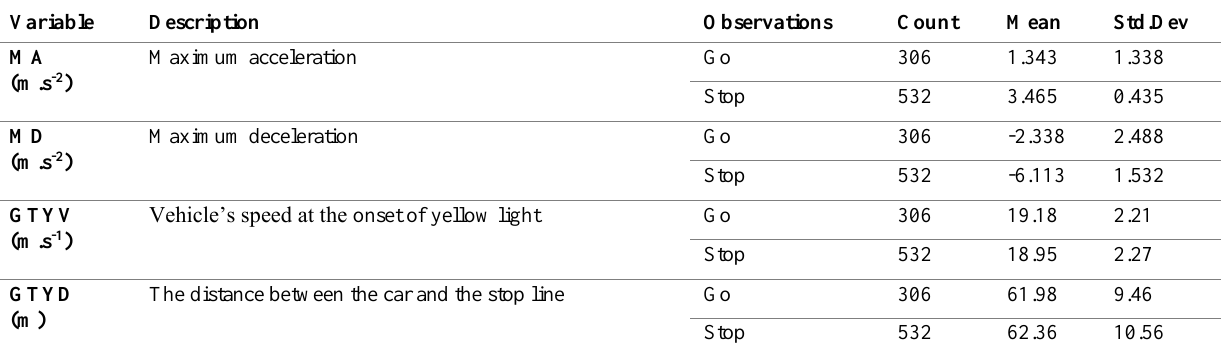
Table 2 . Statistical description of independent variables